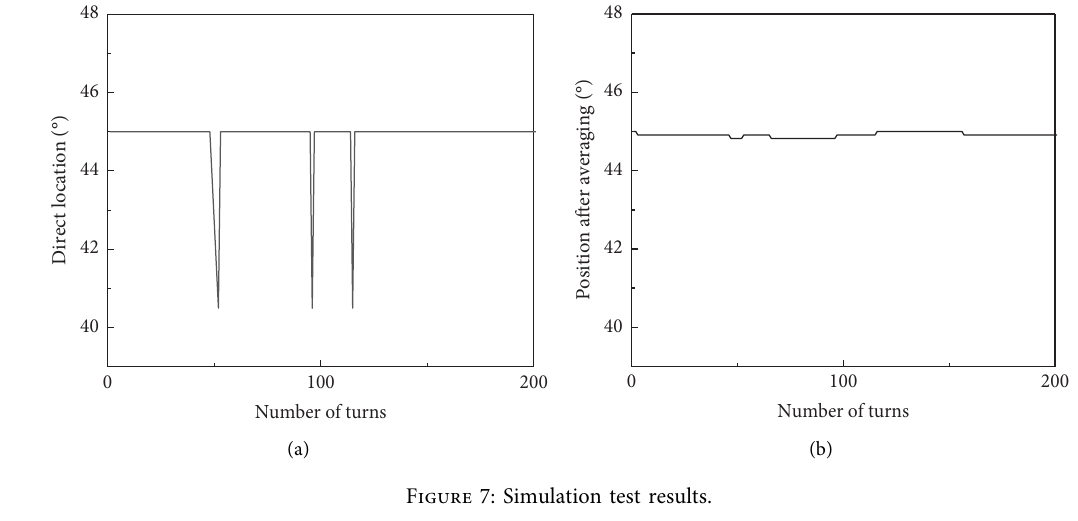
Figure 7: Simulation test results.